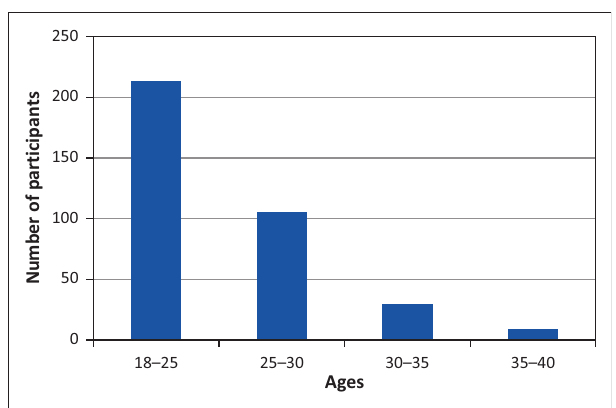
FIGURE 2: Ages of